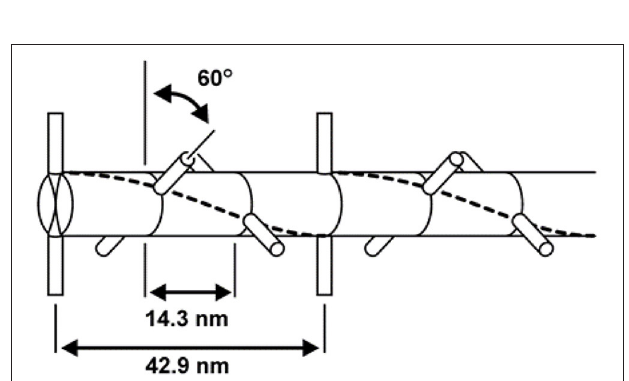
FIGURE 4 | Schematic representation of the thick (myosin) skeletal muscle filament comprised primarily of myosin proteins. Myosin had a tail portion that is incorporated into the main body of the thick filament and two globular heads that reach out from the myosin toward the actin filament. Cross-bridges form cyclic attachments with actin, pulling actin past the myosin filament, thereby producing muscle contraction and force.